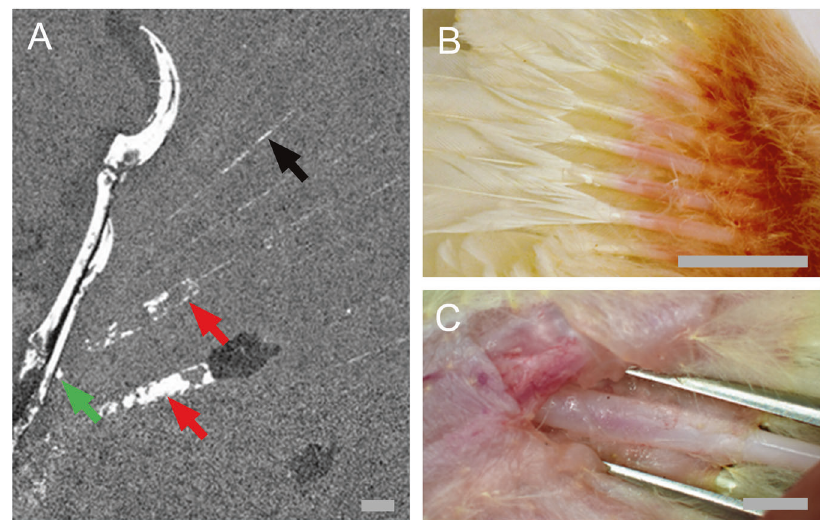
Fig. 1 Overview of feather sheaths on baby chick and phosphorus map of WDC-CSG-100. A Phosphorus (P) map from Bergmann et al. 1 showing high concentration of P in the sheaths vs trace lines of the extended rachis. The two sheaths (red arrows) are also shown separated by one feather. Black arrow is pointing to a feather rachis. Green arrow points to sheath remnant extending to the bone. B Chick feather sheaths in ventral view showing growing feathers and sheath extensions outside of patagia. C Dissected chick patagia showing the feather sheath continuing through the patagia up to the wing bone. Scale bars are 5